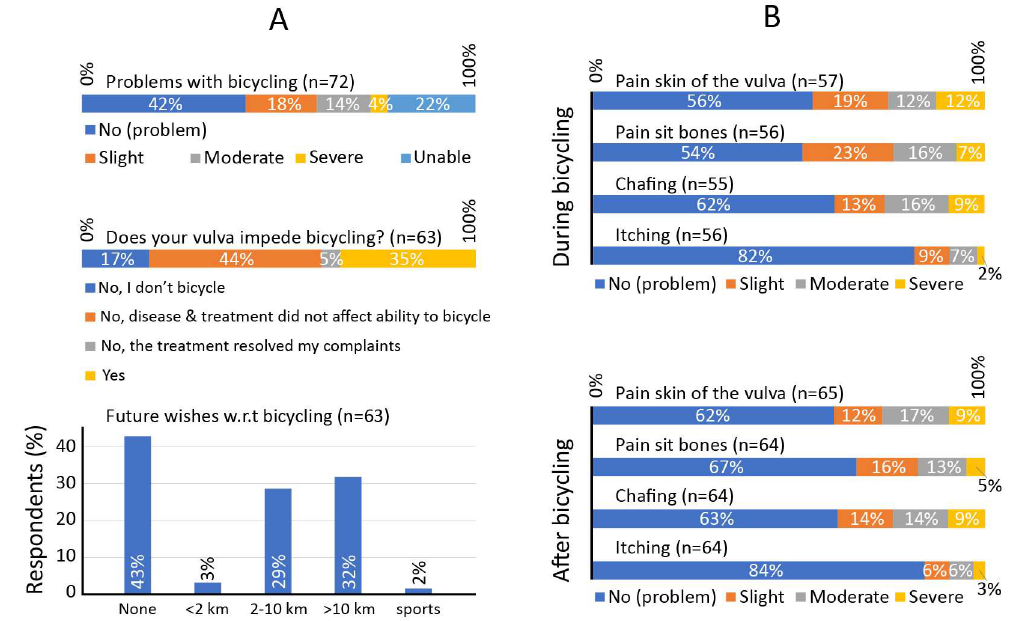
Figure 2. Results of the GO-Bicycling questionnaire, showing the prevalence of problems with bicycling, their relation to problems of the vulva ( A -top), and the desire to bicycle more ( A -bottom). In addition, patient-reported pain or discomfort is reported during and after bicycle use ( B ).